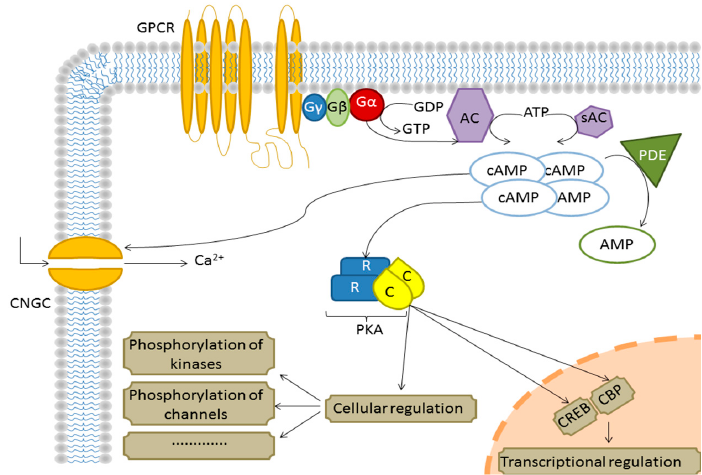
Figure 1. An illustration of some signal transduction pathways mediated by the G-protein coupled receptor based on the animal system. When adenylyl cyclase (AC) is activated by the G α -subunit of the G-protein coupled receptor (GPCR), it catalyzes the formation of cAMP. Cyclic AMP then activates many substrates and kinases such as protein kinase A (PKA) which will regulate many biological processes. Cyclic nucleotide-gated channel (CNGC); soluble adenylyl cyclase (sAC); phosphodiesterase (PDE); cAMP response element-binding (CREB); CREB-binding protein (CBP); catalytic subunit of PKA (C); regulatory subunit of PKA (R).